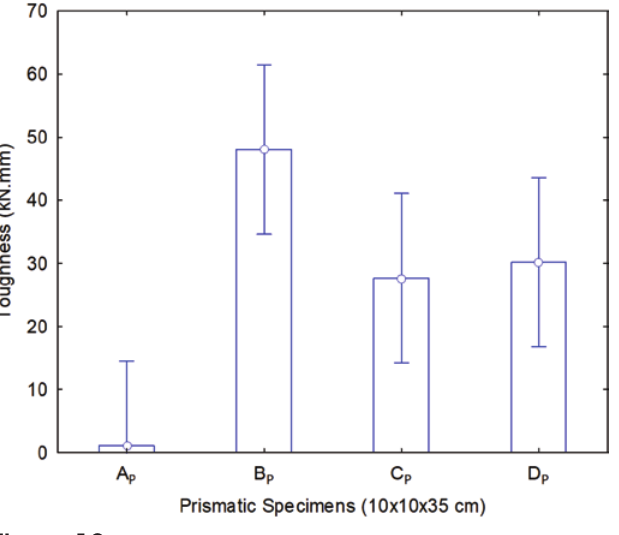
Figure 11 Load versus displacement behavior in prismatic specimens (10 × 10 × 35